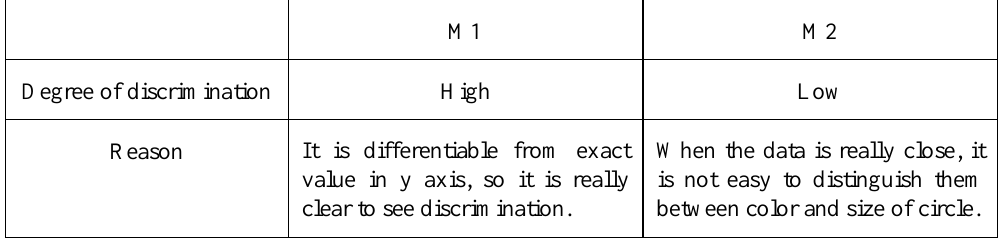
Table 6. A degree of discrimination (when the data is ver close) M1